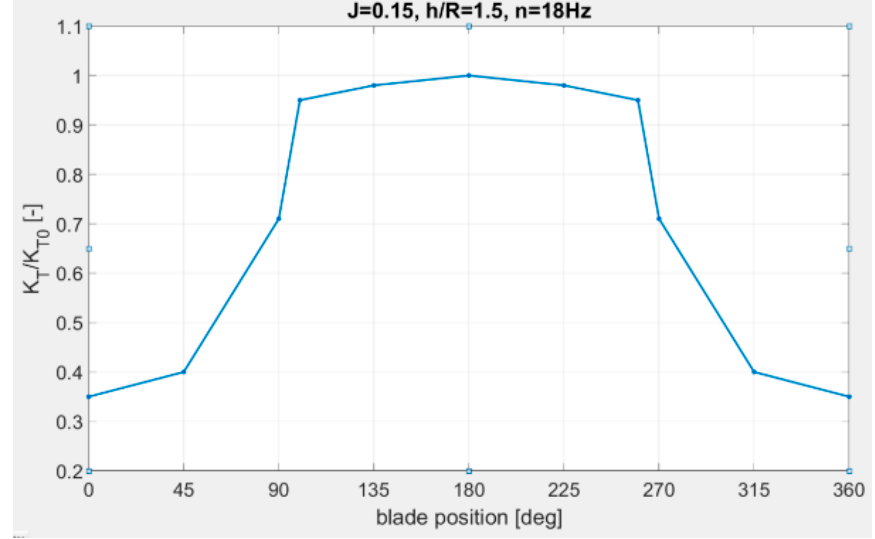
Figure 12. Calculation of thrust loss factor as a function of blade position using the simulation model PropSim (2018_blade_dynamics).